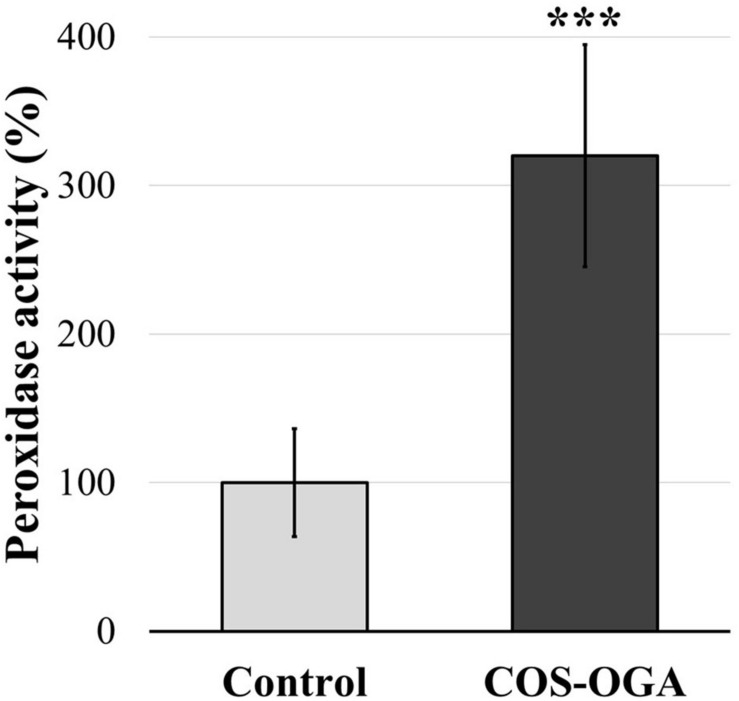
Normalized class III peroxidase activity of tomato leaves after three sprayings with chitooligosaccharides–oligogalacturonides (COS-OGA; 62.5 mg/l). Tomato leaves were harvested 24 h after the third treatment. The average peroxidase activity of the elicited plants is expressed as a percentage of the control ± standard deviation (n = 12). ***indicates a statistically significant difference to control according to Student’s t test (p < 0.001, R).